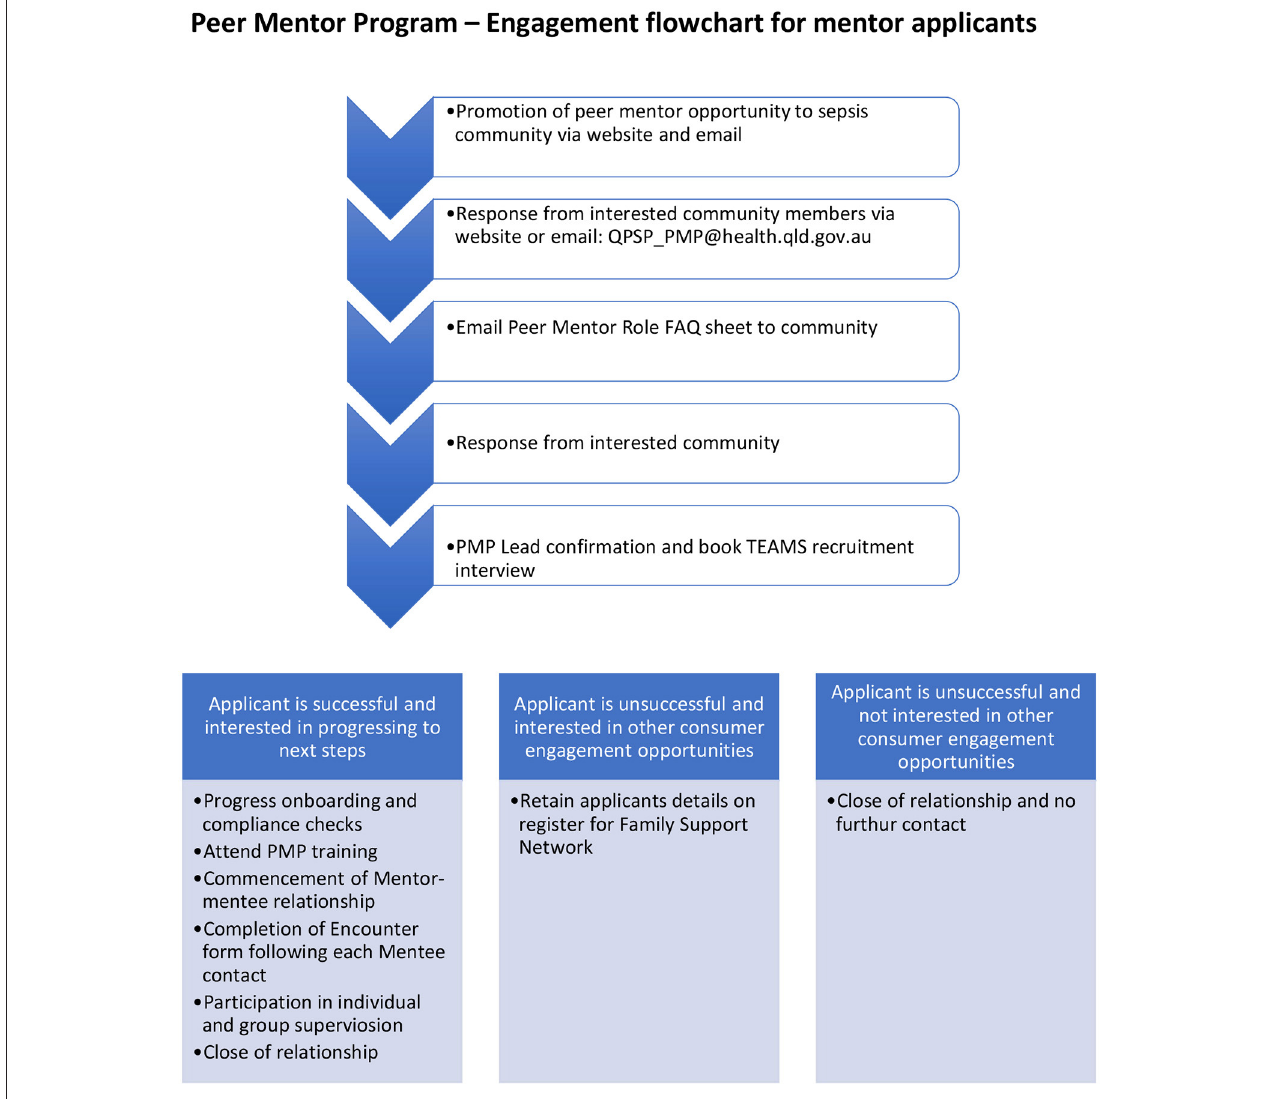
FIGURE 2 | Peer mentor program engagement